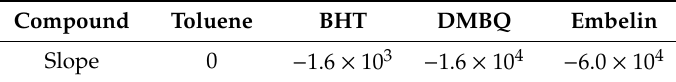
Table 1. Slopes of collection e ffi ciency from Figure